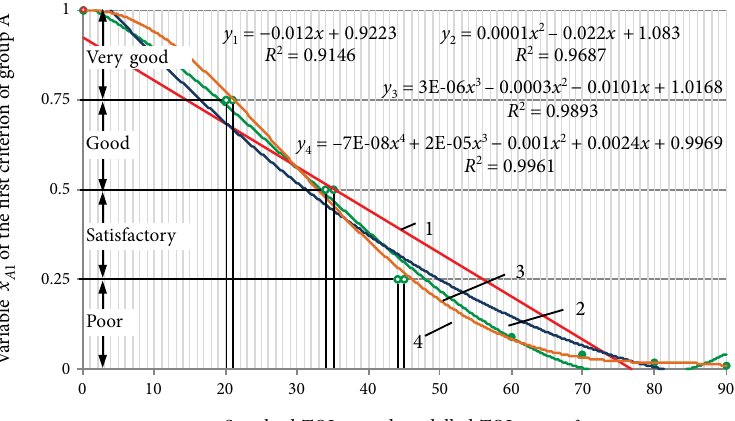
Fig. 5. Various regression equations describing the values of standard track quality index TQI